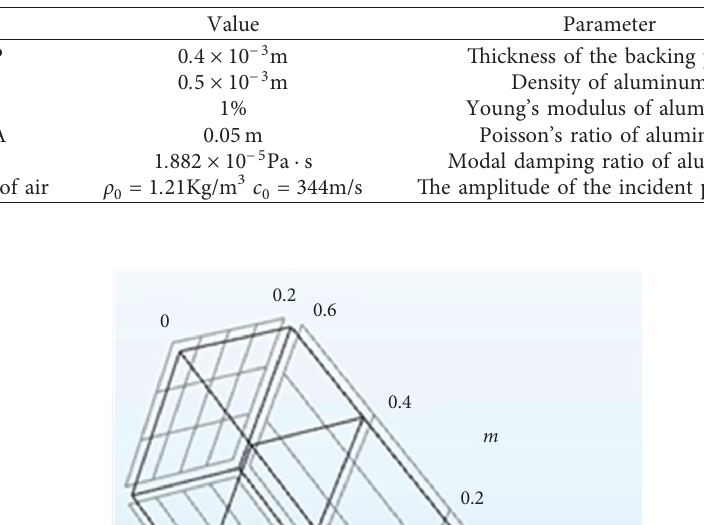
Table 1: The geometric and material parameters of the model.